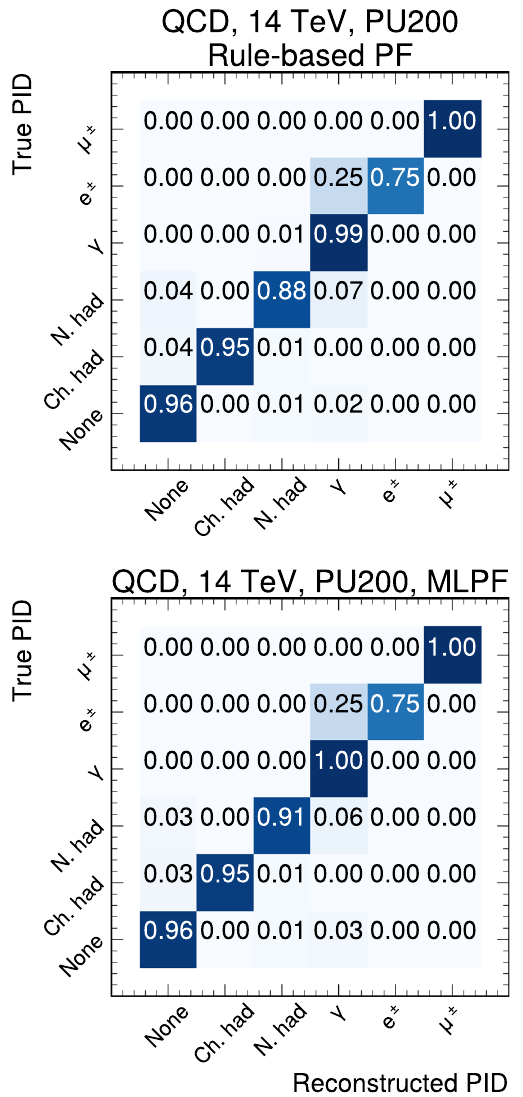
Fig. 6 Particle identification confusion matrices in simulated QCD multijet events with PU, with gen-level particles as the ground truth, showing the baseline rule-based delphes PF (upper) and the MLPF (lower) outputs. The rows have been normalized to unit probability, corresponding to normalizing the dataset according to the generated PID 2070S GPUs using data parallelism on 40,000 simulated